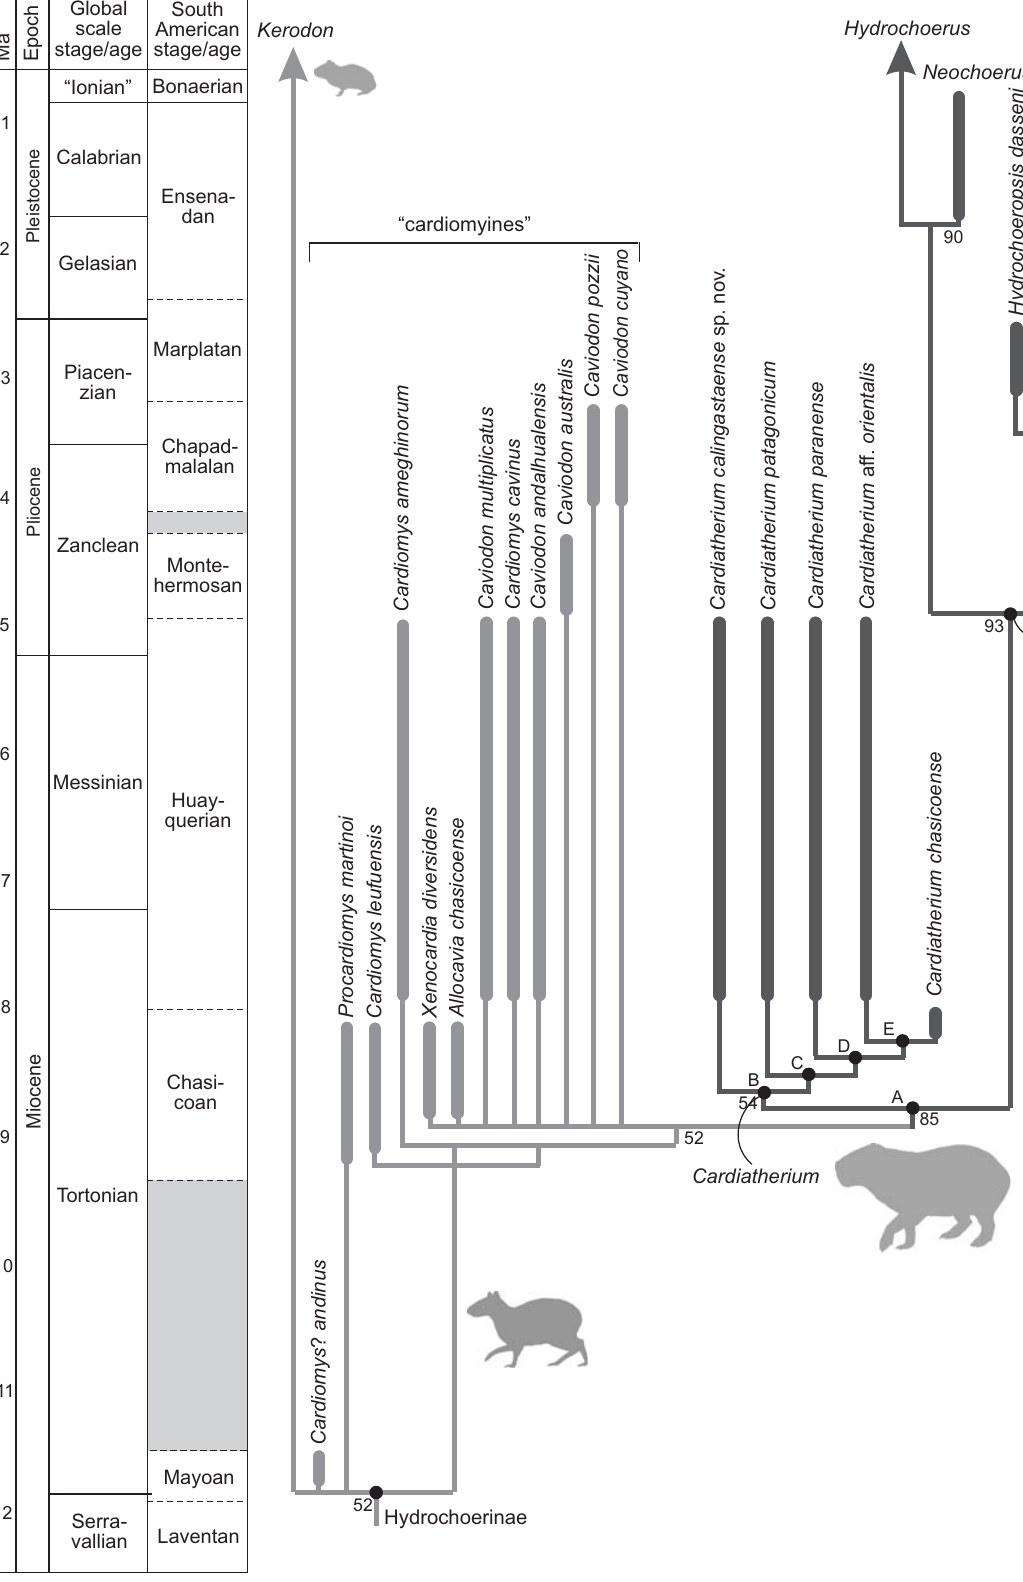
Fig. 7. Stratigraphic adjustment of the strict consensus tree for the phylogenetic analysis of Hydrochoerinae (333 MPTs of 3364 steps). Upper case letters indicate the nodes within Hydrochoerinae, as described in the main text. Silhouettes reflect external aspect and relative size of representatives of the main clades within